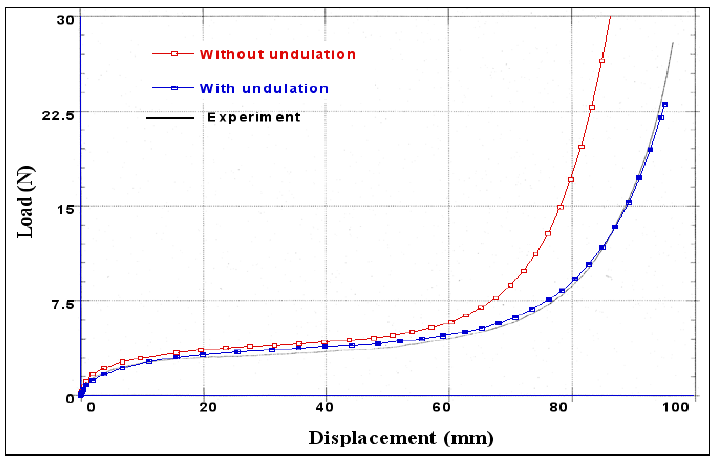
Figure 8. Effect of the fibre undulation of the force versus displacement